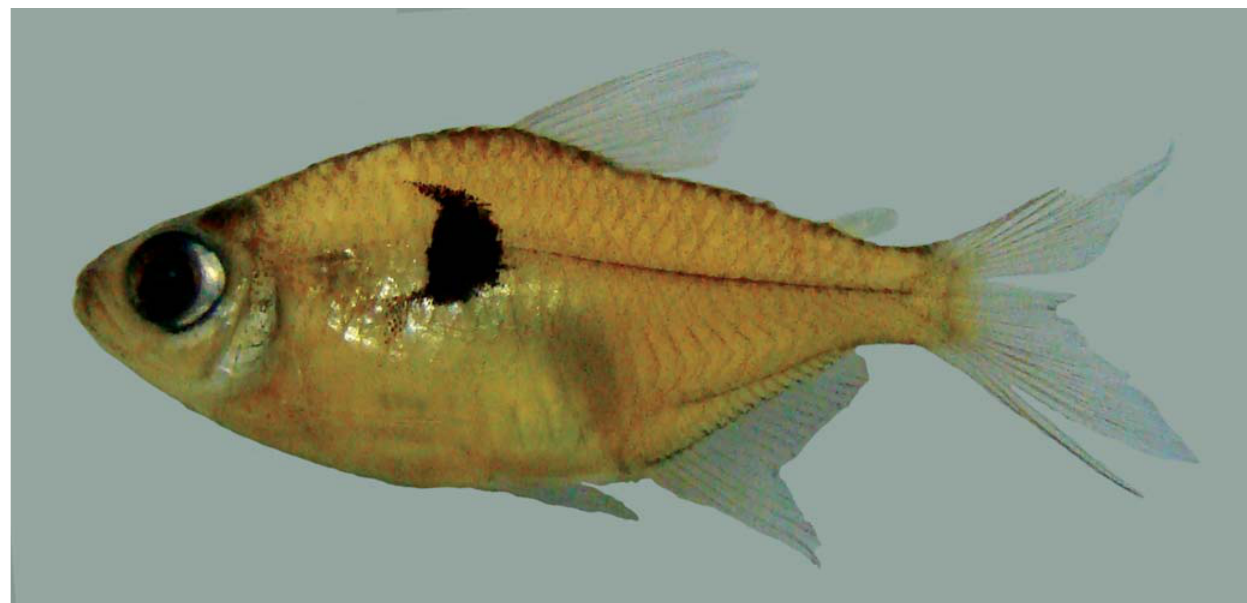
Fig. 2. Hemigrammus arua , paratype, MPEG 14757, 25.4 mm SL: Brazil, Pará State, município de Juruti, lago São Francisco do Alto